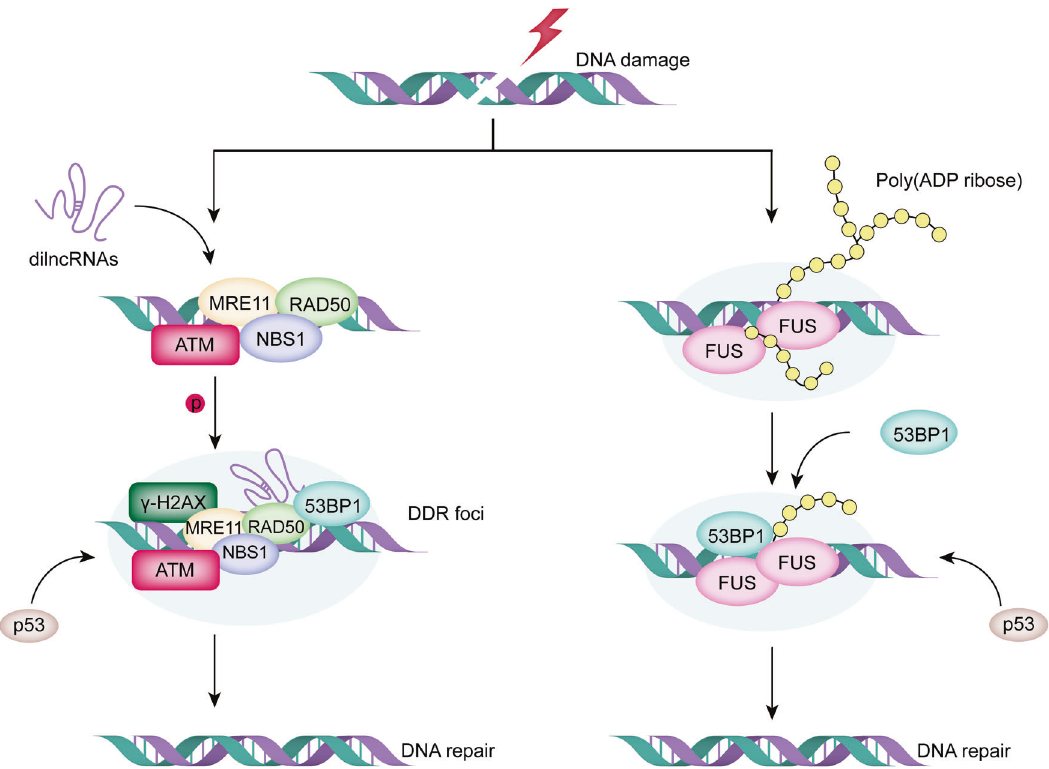
Fig. 2 LLPS supports various DNA damage response (DDR) mediator to form DNA repair foci in different pathways. (Left) MRE11 – RAD50 – NBS1 complexes bind to the exposed DNA damage sites to initiate the pathway. Subsequently, the damage-induced lncRNAs (dilncRNAs) and P53- binding protein 1 (53BP1) are recruited to the DDR site to promote the formation of DNA damage repair foci via LLPS. (Right) Nucleation of PAR with FUS and 53BP1 at DDR sites forms liquid-like compartments and facilitates subsequent signaling and